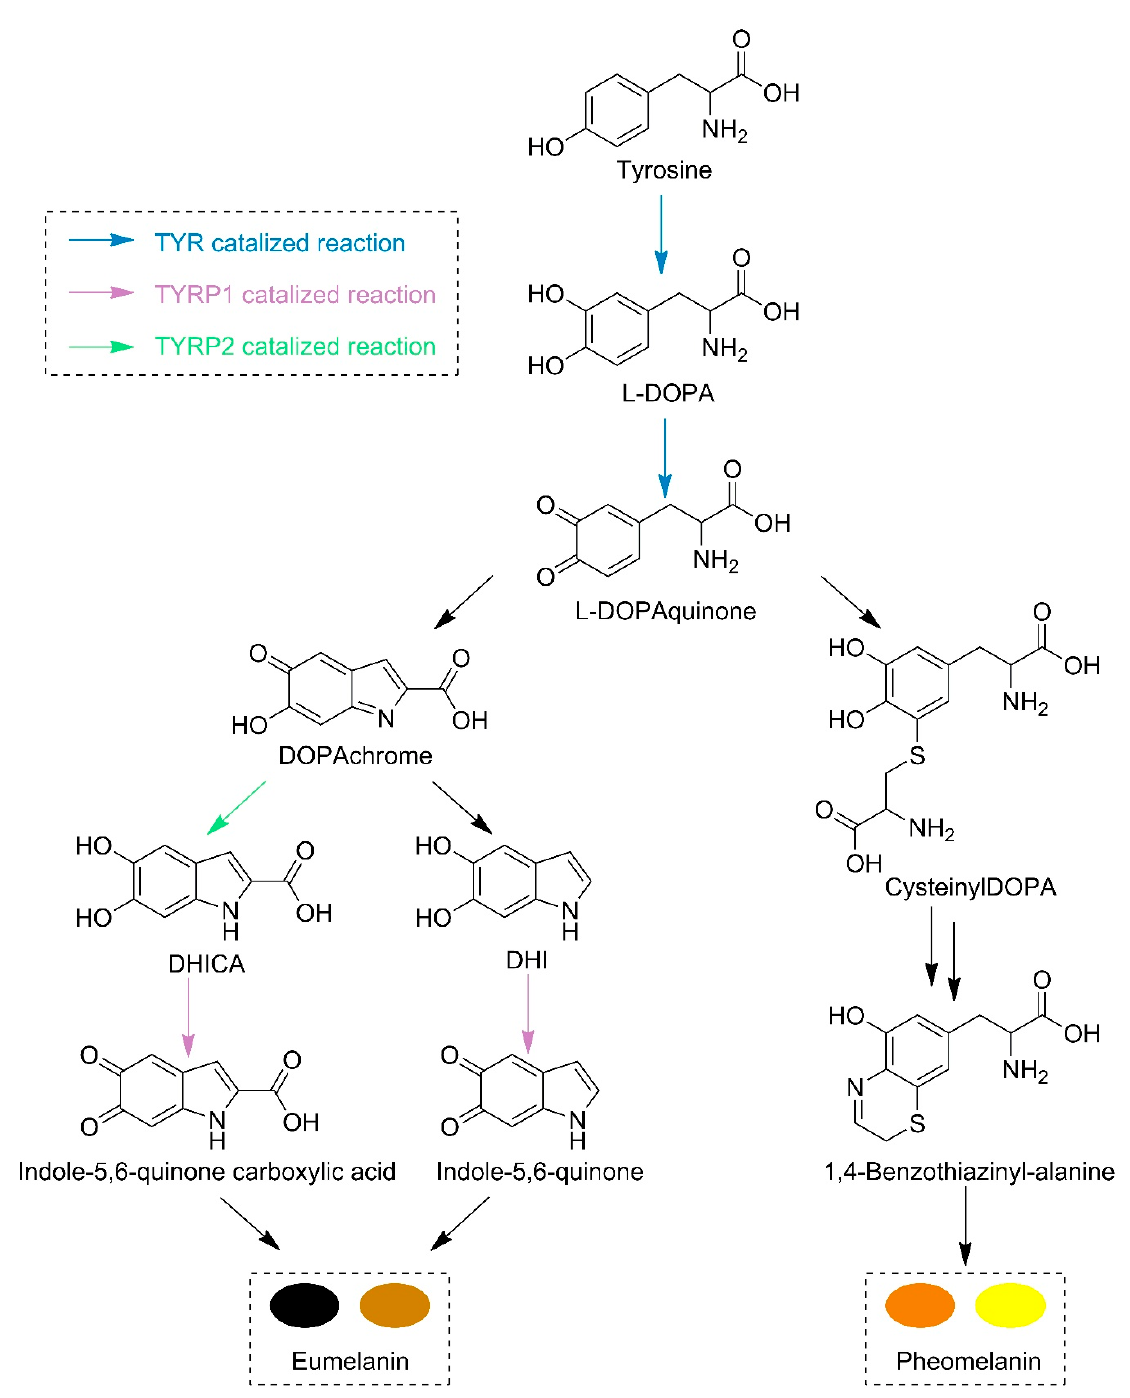
Figure 1. Proposed melanin biosynthesis involving the three tyrosinase ‐ related proteins.